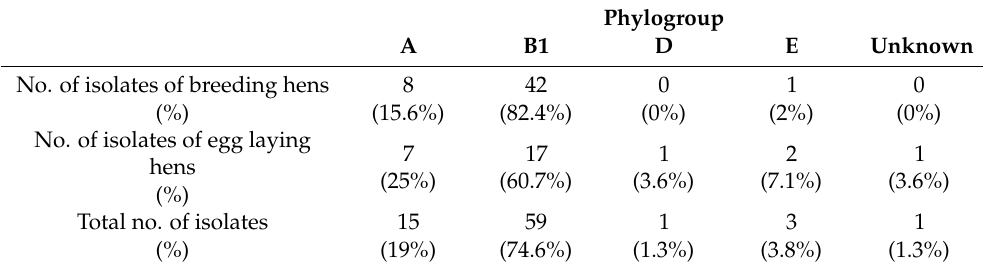
Table 2. Number of samples of laying and breeding hens analyzed, and number of isolates of E. coli resistant to ampicillin or enrofloxacin selected for further characterization. Samples Source No. of Samples No. of Isolates Breeding hens 31 Egg laying hens 29 28